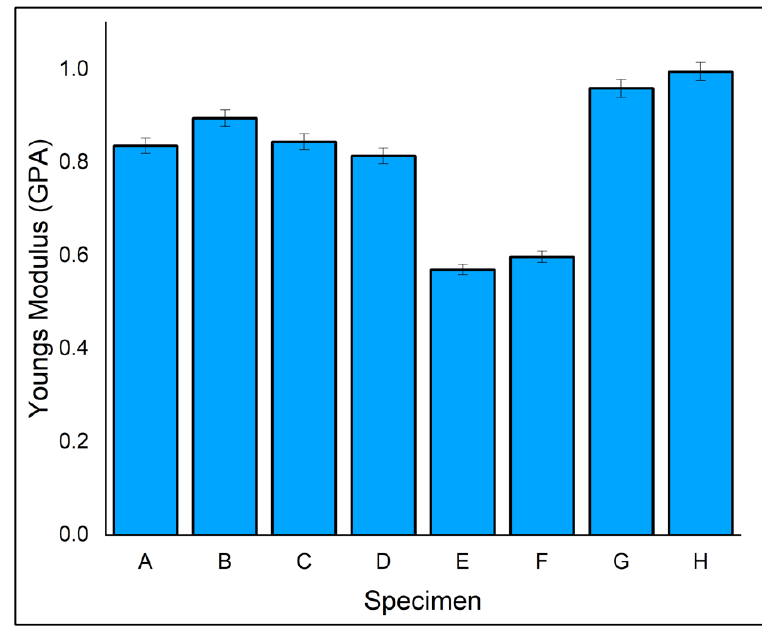
Figure 6. Young’s modulus of the composite.